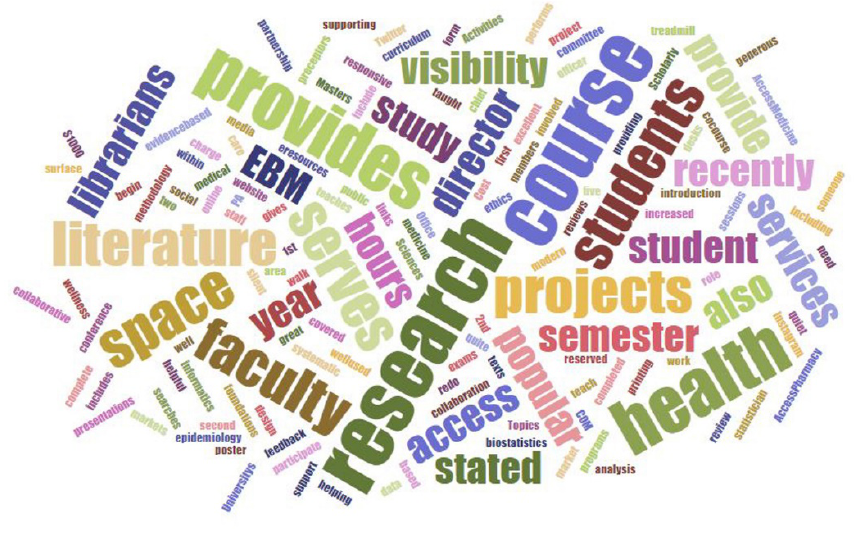
Figure 4 Wordle cloud from phase three interviews, question